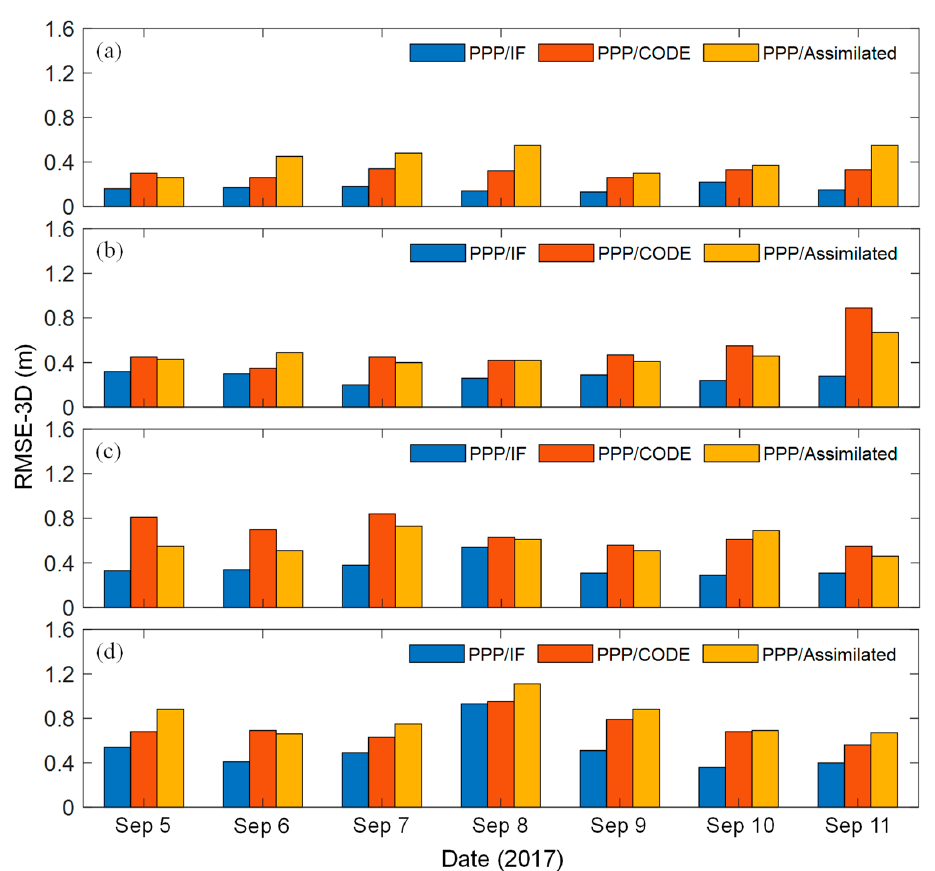
Figure 11. RMSE of 3D with each day at different stations from 5 September 2017 to 11 September 2017. ( a ) GAMG; ( b ) JFNG; ( c ) LHAZ; ( d ) CMUM.